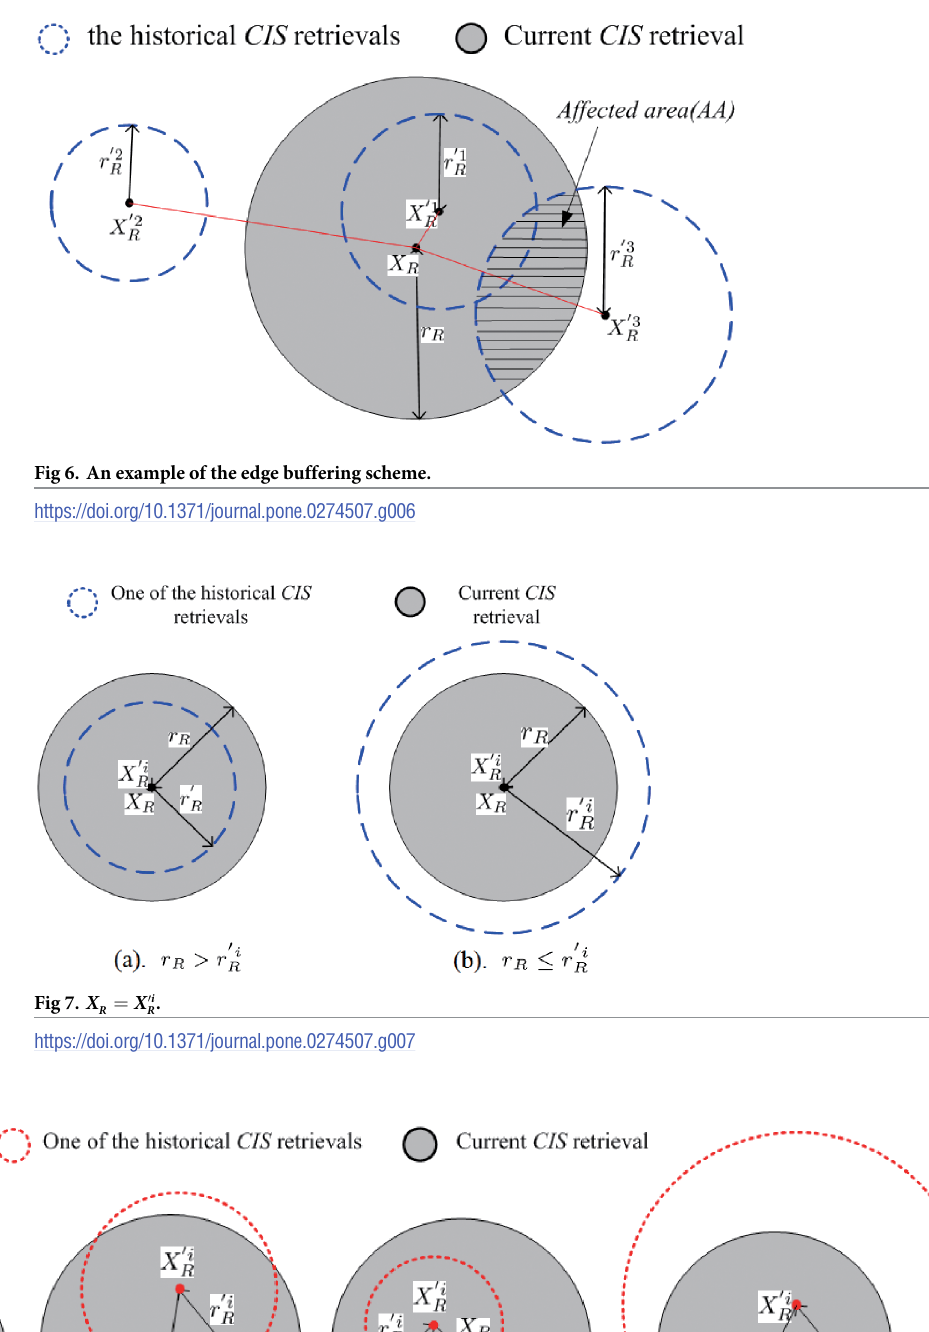
6¼ X 0 i , ( a ). AA ð Y ð X R R ; r Þ ; Y ð X 0 i ; r 0 i ÞÞ ¼ Y ð X R R R R